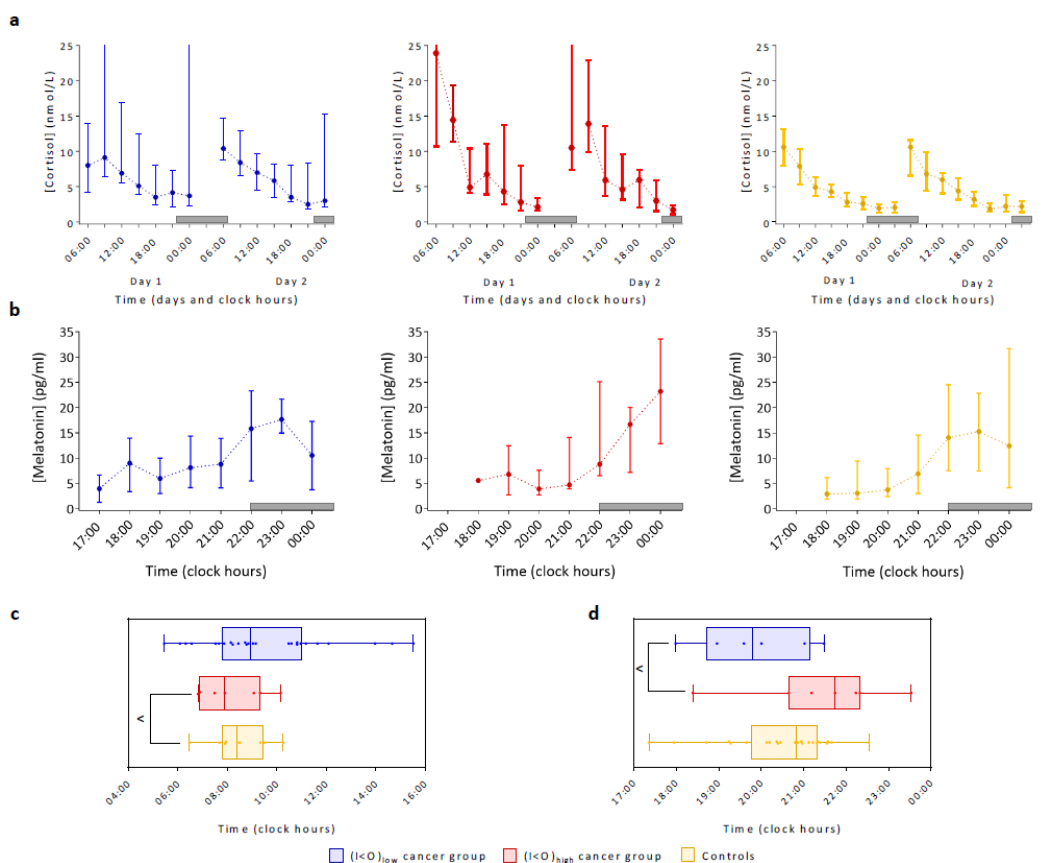
Figure 6. Daily patterns in salivary cortisol and melatonin concentrations in cancer patients and in controls. ( a ) Circadian changes in salivary cortisol over two consecutive days in the (I < O) low patients (blue), in the (I < O) high patients (red) and in the controls (yellow). ( b ) Hourly changes in evening salivary melatonin concentrations in the (I < O) low patients (blue), in the (I < O) high patients (red), and in the controls (yellow). ( c ) Box plots of cortisol circadian acrophase in both I < O patients’ groups and in controls. ( d ) Box plots of dim light melatonin onset (DLMO) in both I < O patients’ groups and in controls. In ( a , b ), bars represent the interquartile ranges and dots plot the median values. The grey bar on the abscissa represents the night span (22:01 to 07:00). Levels of significance: ˆ 0.05 < p ≤ 0.1 (two-tailed Welch’s modified t